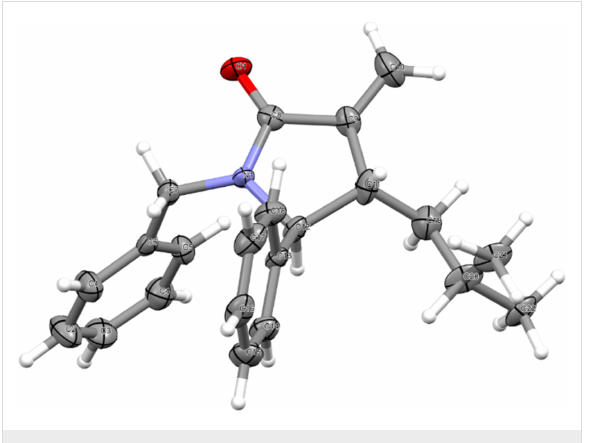
Figure 1: X-ray crystal structure of compound 19l